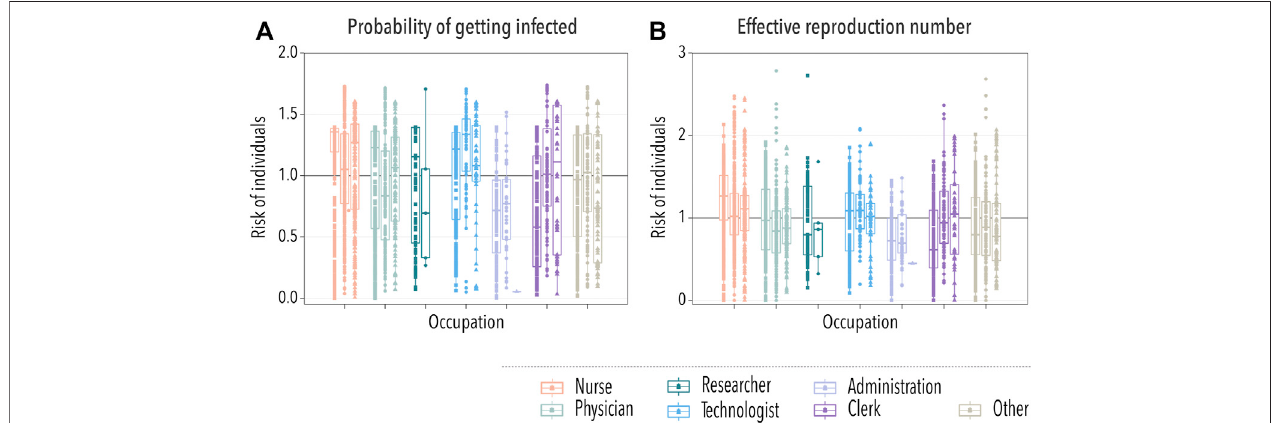
FIGURE4| SpreadingofthediseaseacrossHCWs.Inallcases,eachbox-plotrepresentsthemedianandinterquartilerangeoftheriskassociatedwitheachgroup of HCWs. Dots indicate the average risk of each worker within the category, with squares, circles, and triangles representing workers from hospitals A, B, and C, respectively. In panel (A) , we show the relative risk measured as the probability of getting infected during an outbreak. In panel (B) , the risk is gauged using the average number of infections produced by an individual during an outbreak.